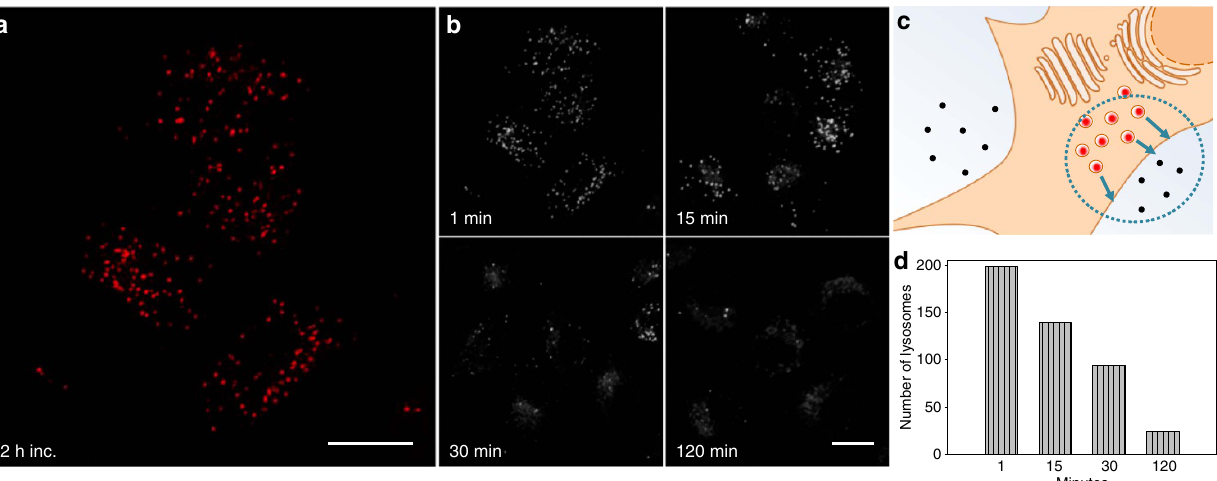
Figure 11 | Imaging of cellular efflux. HeLa Kyoto cells were pre-treated with 2 (10 m M) for 2h, DMEM replaced with fluorophore-free DMEM and cells fixed at various time points. ( a ) Cells imaged after 2h incubation. ( b ) Cells imaged after 1, 15, 30 and 120min post media change. ( c ) Schematic depiction of efflux of bioresponsive fluorophore. ( d ) Decrease in number of NIR fluorescent lysosomes from 1 to 120min. Scale bars, 20 m m.